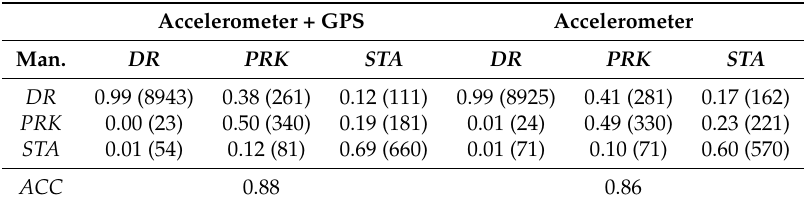
Table 16. Fine-grained classifier’s confusion matrices with and without GPS enrichment.